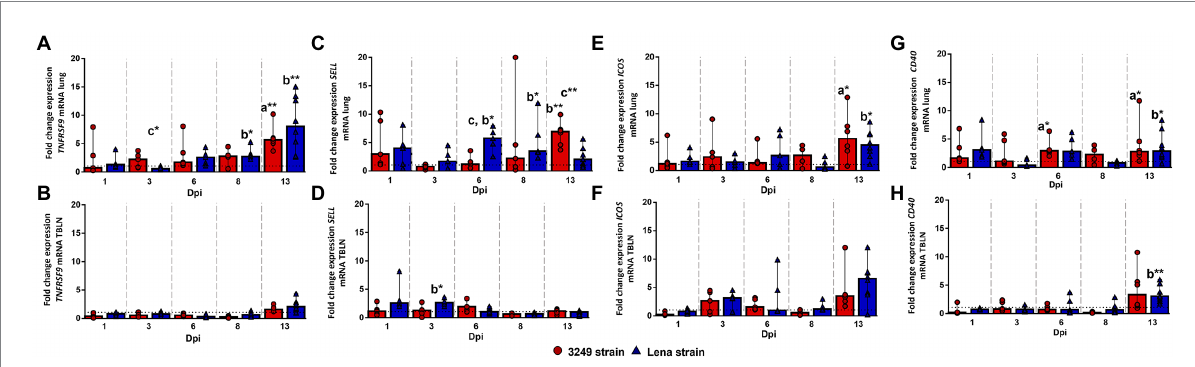
FIGURE 7 Relative mRNA expression of TNFRSF9 , SELL, ICOS and CD40 mRNA. Graphs show fold change expression of TNFRSF9 mRNA in lung (A) and tracheobronchial lymph node (TBLN) (B) , of SELL mRNA in lung (C) and tracheobronchial lymph node (TBLN) (D) , of ICOS mRNA in lung (E) and tracheobronchial lymph node (TBLN) (F) and of CD40 mRNA in lung (G) and tracheobronchial lymph node (TBLN) (H) . Columns represent median with interquartile range (IQR). Individual values for each animal from low virulent 3249- (red circles) and virulent Lena- (blue triangles) infected animals are depicted. Dashed line represents the expression of TNFRSF9 , SELL, ICOS and CD40 mRNA from control group in each organ. “a” indicates a significant difference between the 3249 and control groups, “b” between Lena and control groups and “c” between Lena and 3249 groups (* p ≤ 0.05 and ** p ≤ 0.01). Dpi, days